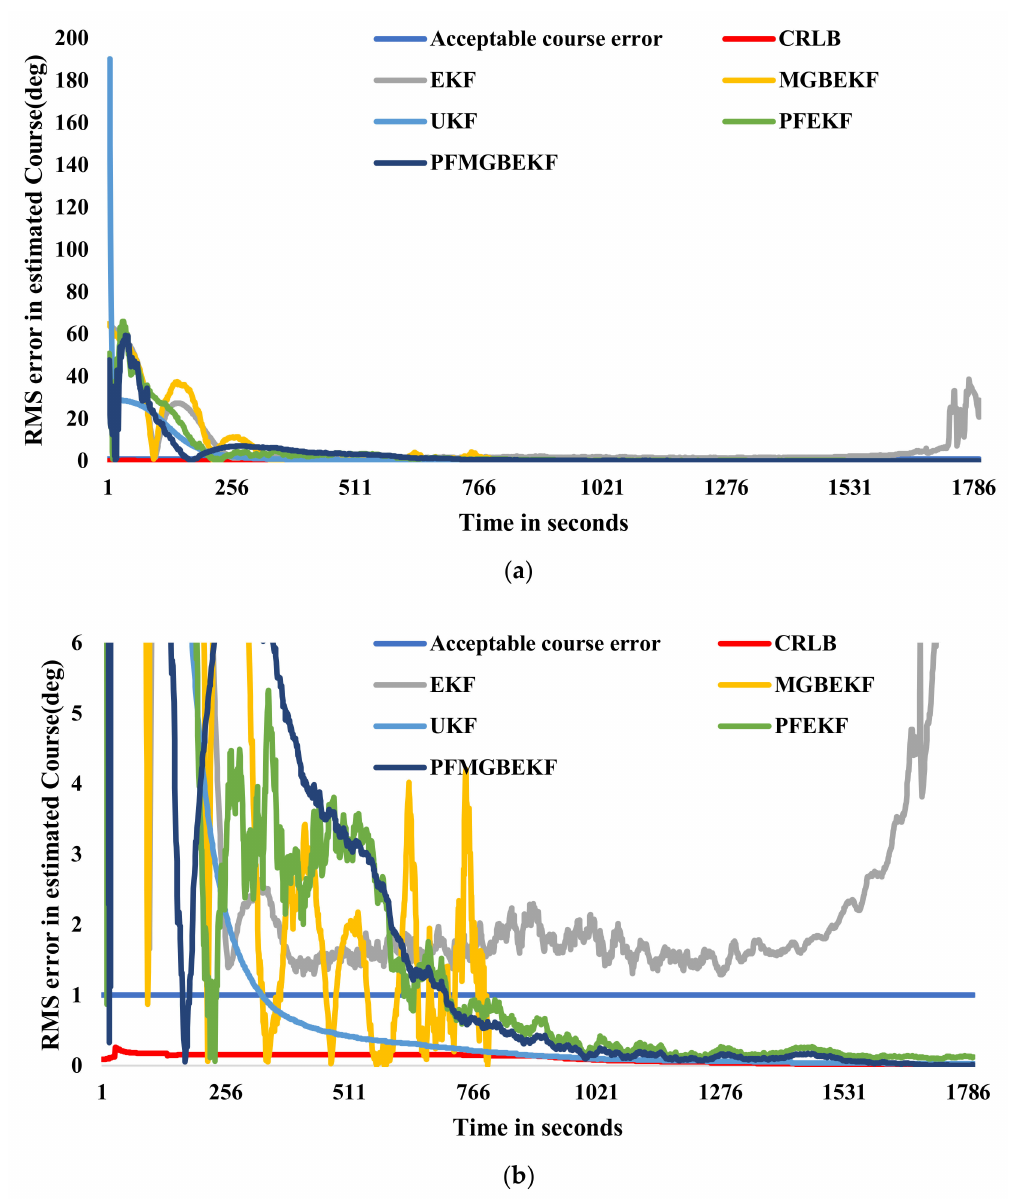
Figure 9. RMS error in course estimate of the target for scenario 3. ( a ) RMS error in course estimate of the target. ( b ) Expanded view of Figure